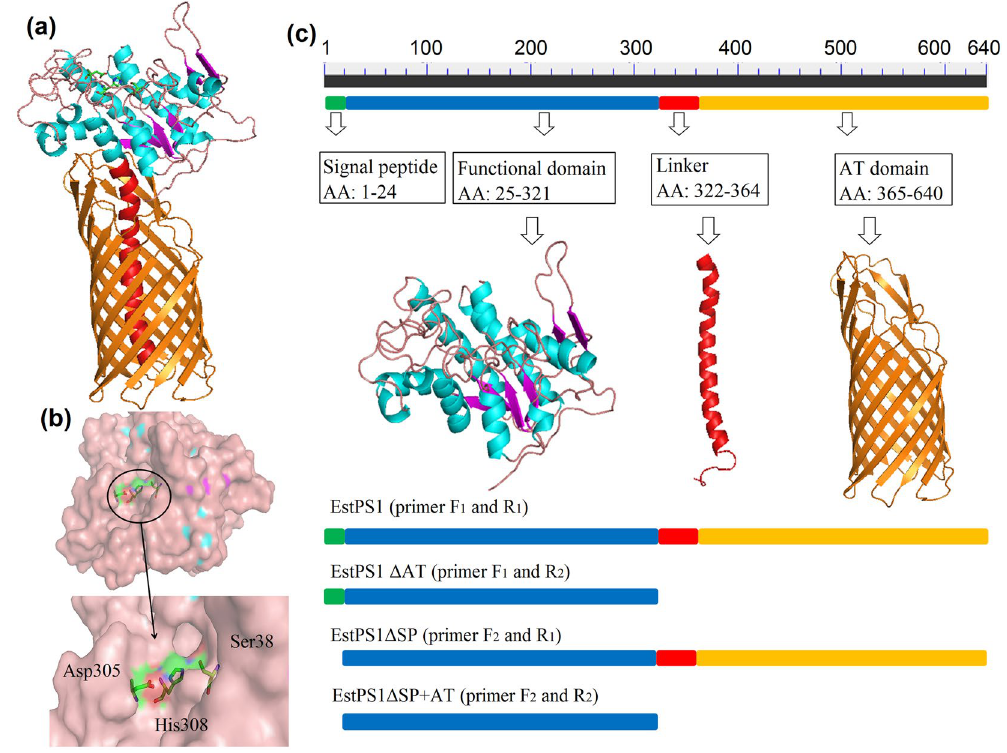
Figure 2. The protein model and conserved domain analysis. ( a ) 3D model of EstPS1. ( b ) The catalytic site (Ser 38 , Asp 305 , and His 308 ) labelled in the 3D model. ( c ) Conserved domain analysis and AT domain expression strategy (EstPS1, EstPS1 Δ AT, EstPS1 Δ SP, and EstPS1 Δ SP + AT).